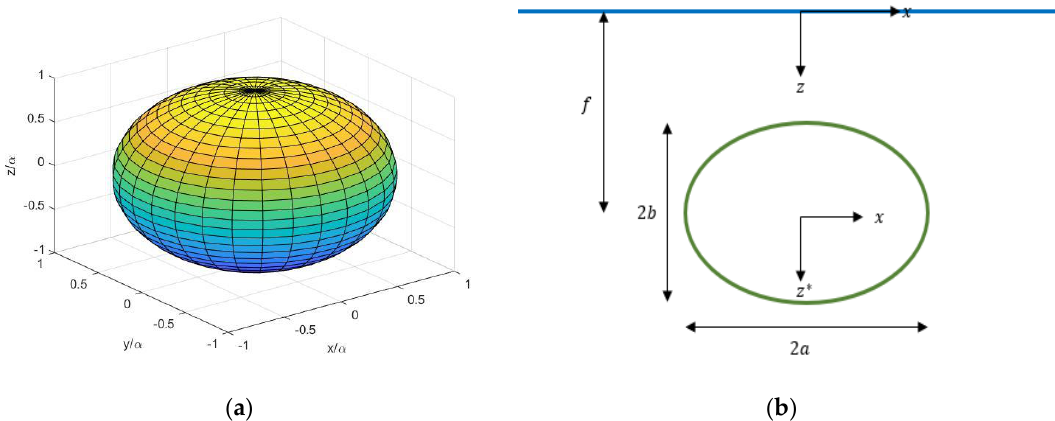
Figure 1. ( a ) A 3D image of an axisymmetric oblate spheroid; ( b ) A 2D schematic of the problem in the 𝑥 − 𝑧 plane. x − z